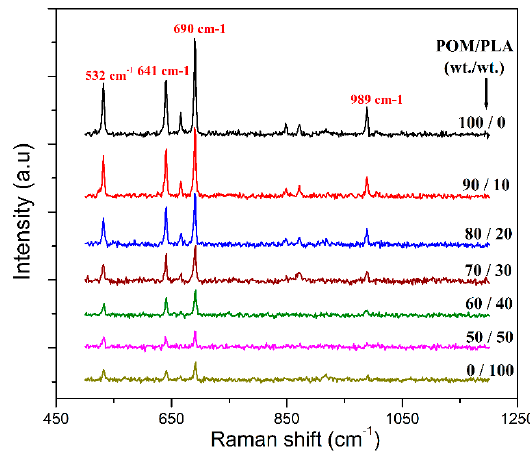
Figure 4. Raman spectra of pure POM, PLA and their blends.